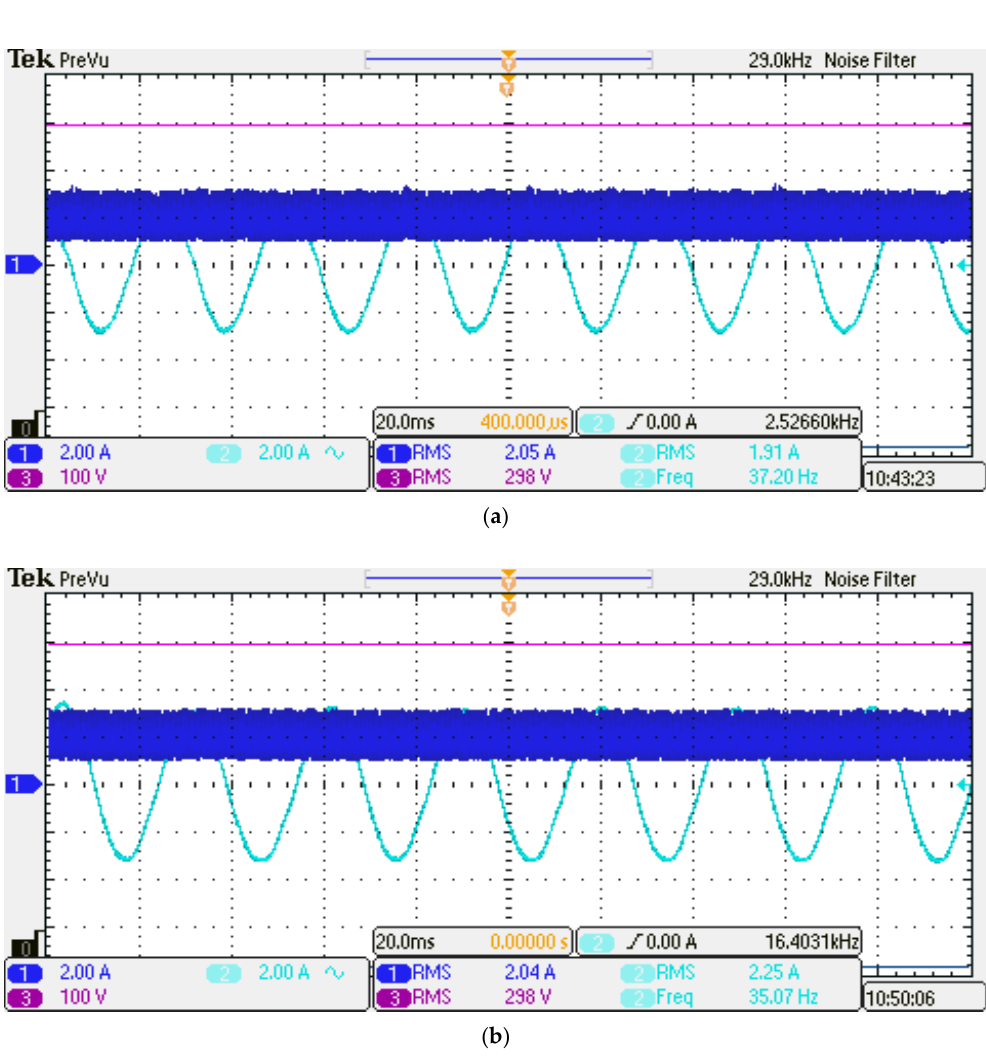
Figure 11. Experimental results at 2 A of the inductor current: ( a ) the proposed Q V/f; ( b ) the conventional L V/f PI-PI (Trace 1: Inductor current, Trace 2: Inverter phase current, Trace 3: DC-link voltage).